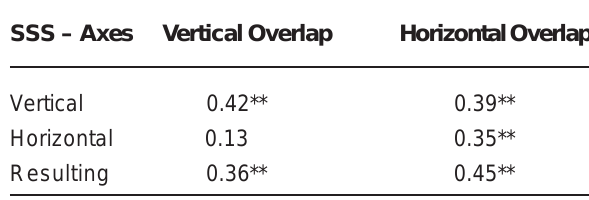
TABLE 3- Pearson’s correlation coefficients for Group I (n = 61). SSS and overlaps